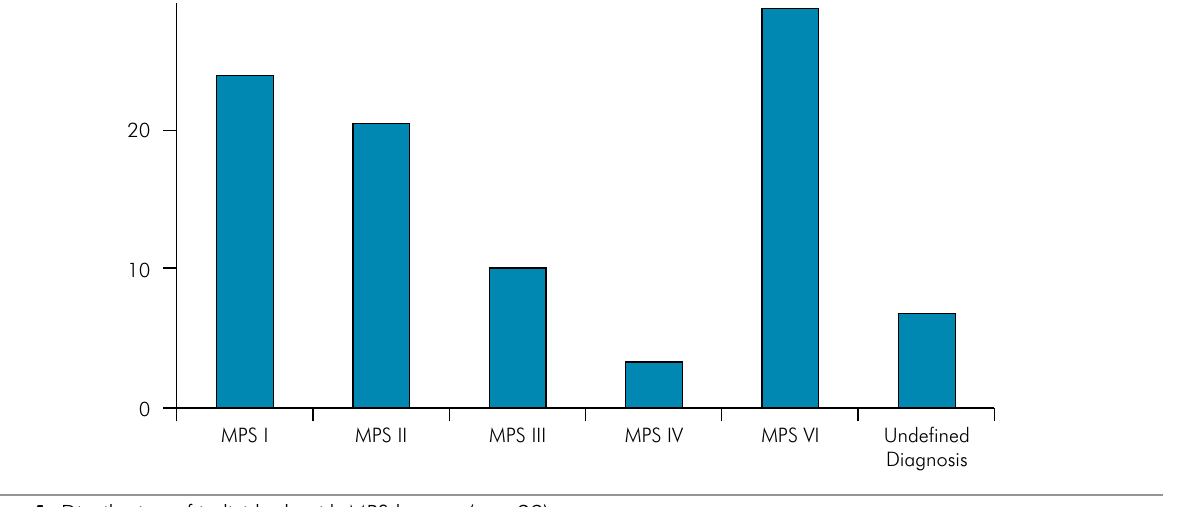
Figure 1. Distribution of individuals with MPS by type (n =